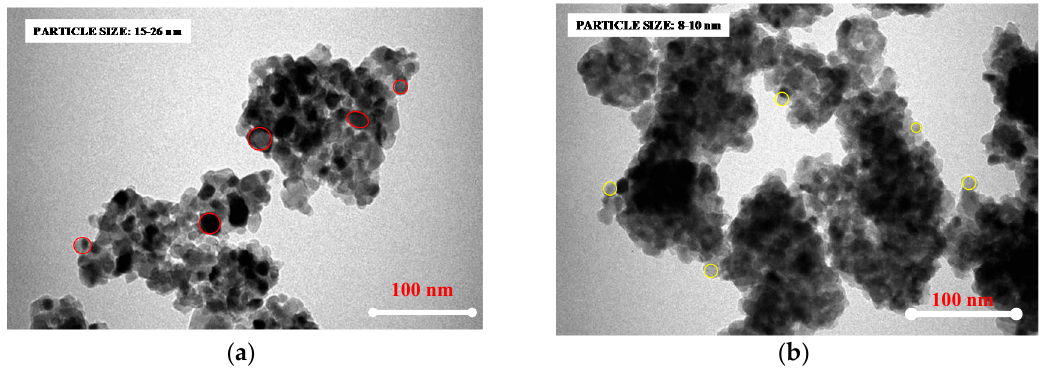
Figure 4. TEM micrographs of the as synthesized TiO 2 nanomaterials prepared without CHE ( a ) and with CHE ( b ).